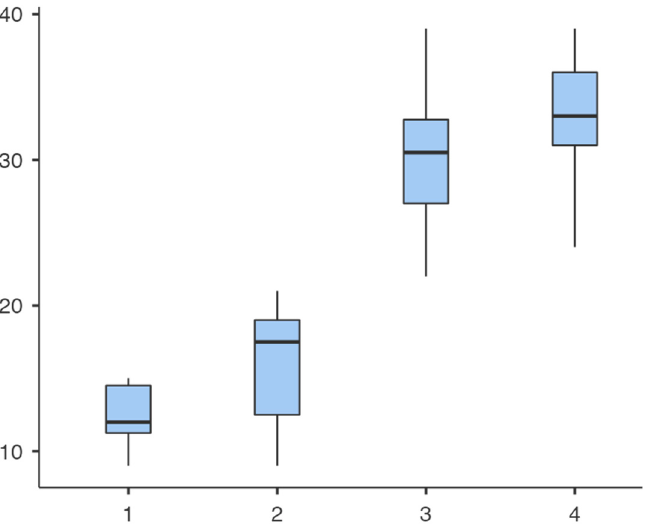
Figure 2. The index of involution changes of the skin in patients of the main group and the comparison group, where on the axis OX: 1—patients 35–40 years from the comparison group; 2—patients 41–45 years from the comparison group; 3—patients 35–40 years from the main group; 4—patients 41–45 years from the main group. The sum of points is reflected on the axis OY vertical.